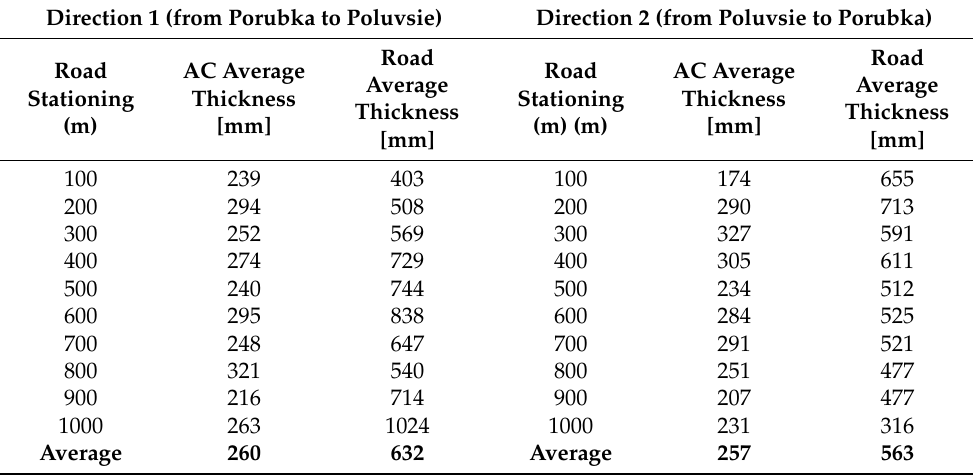
Table 2. Example of GPR measurement evaluation (date 9 December 2020). Direction 1 (from Porubka to Poluvsie)